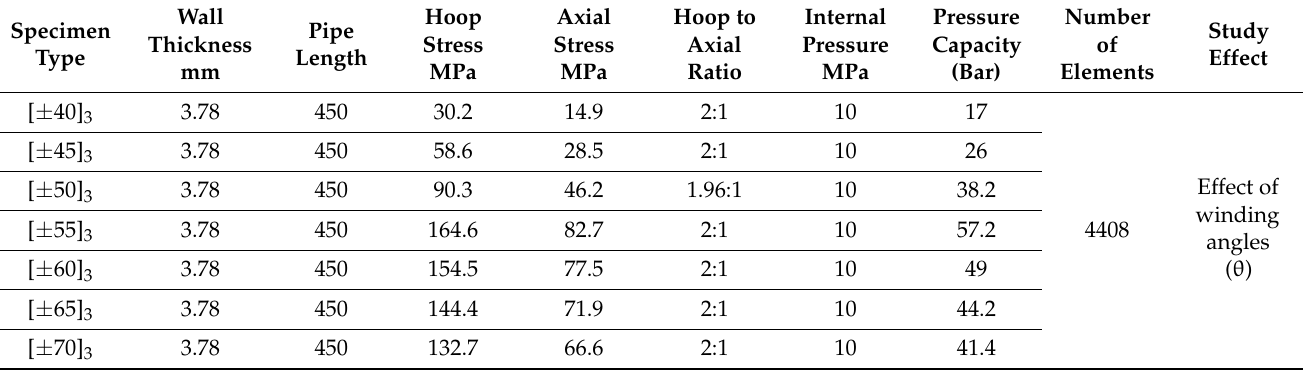
Table 5. GFRP pipe and simulation input/output